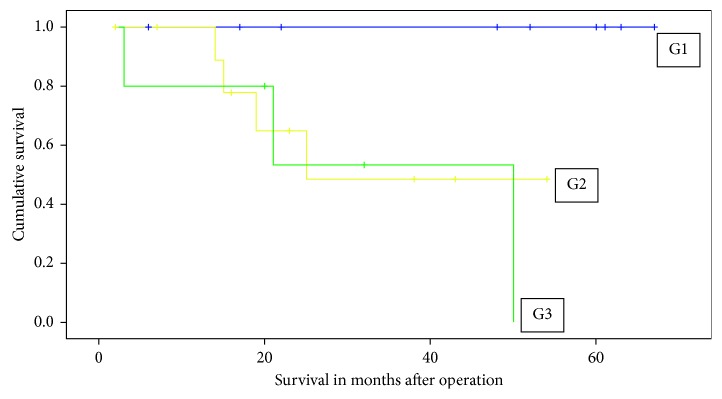
Tumor grade (G1/G2/G3) and overall survival (p=0.023).